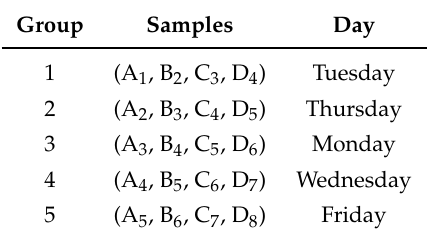
Table 4. The order of grouping the salmon samples from different storage days (represented by the corresponding subindex) and the day each group was provided to the